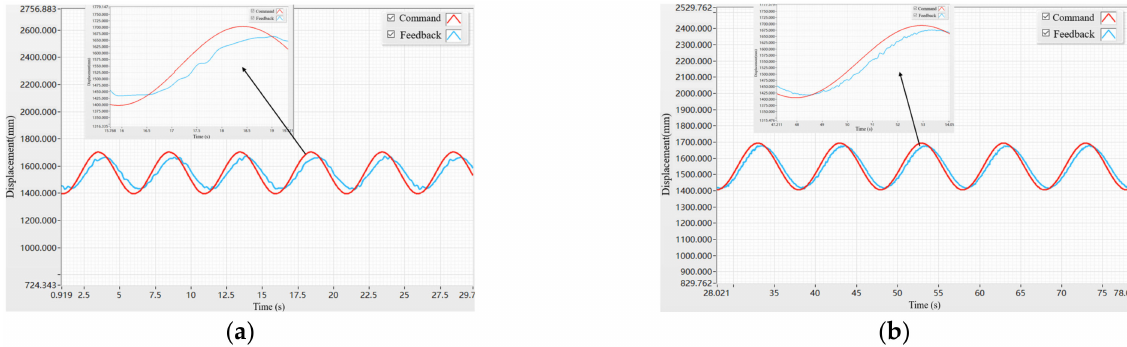
Figure 21. ( a ) Sine response displacement curve of PID; ( b ) Sine response displacement curve of ADRC.